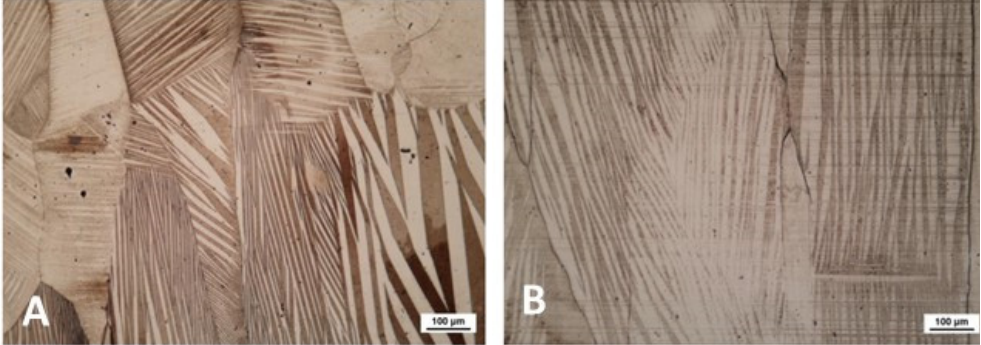
Figure 1. Optical microscopy observations for samples A ( A ) and B ( B ). Strain recovery measurements vs. T under different stresses were carried out in the [210–480 K] temperature range and in the [50–200 MPa] stress range through compres- sion